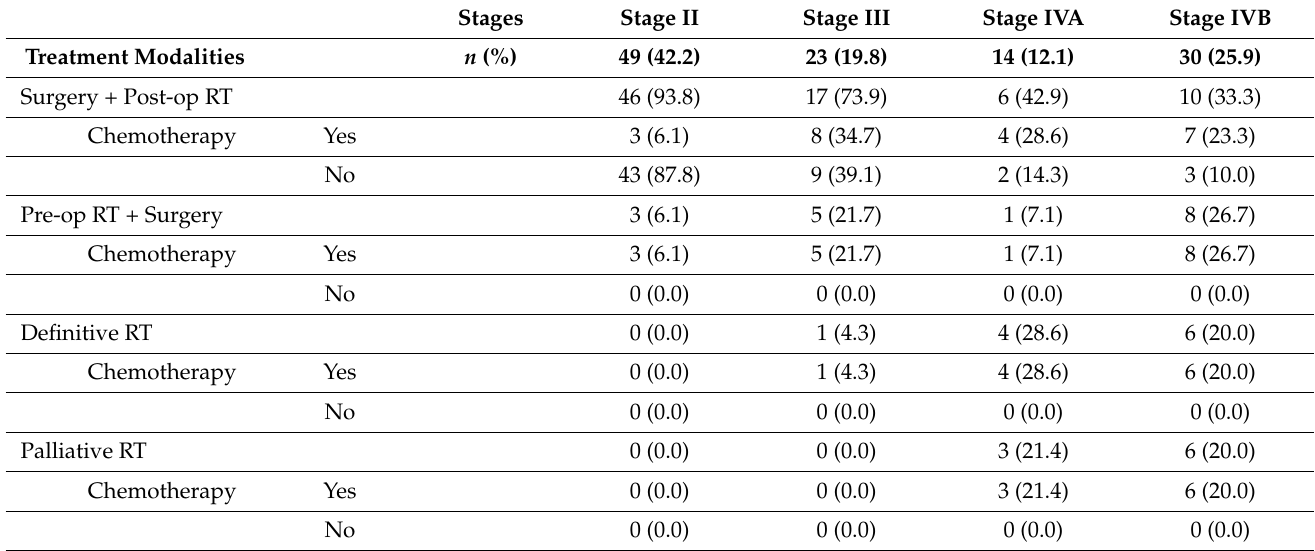
Table 2. Use of treatment modalities according to the Masaoka